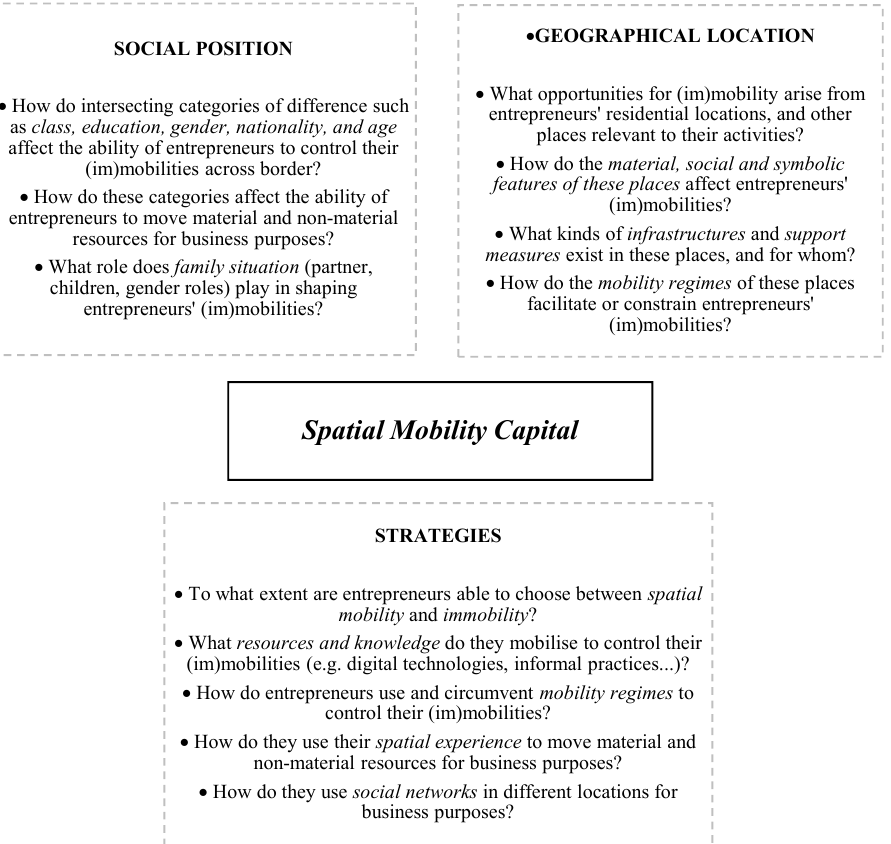
Figure 4. Dimensions and questions used in the study to empirically understand unequal opportunities in using transnational schemes.